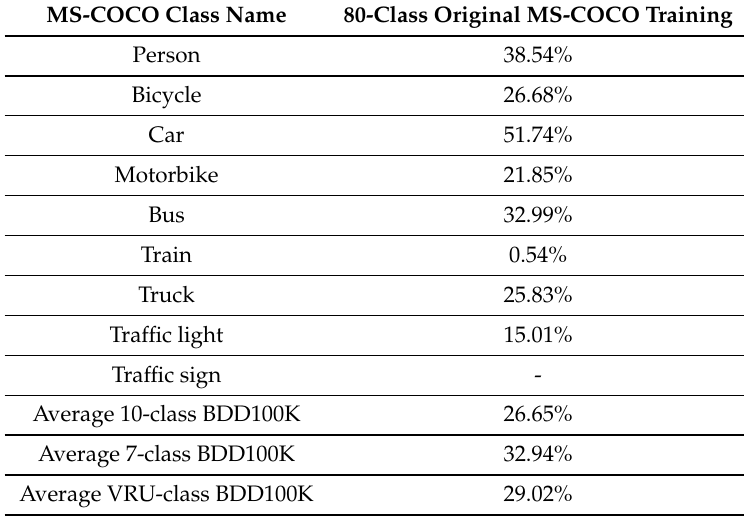
Table 3. AP50 for each class with the original MS-COCO-trained YOLOv3 model from the author when applied to the BDD100K test